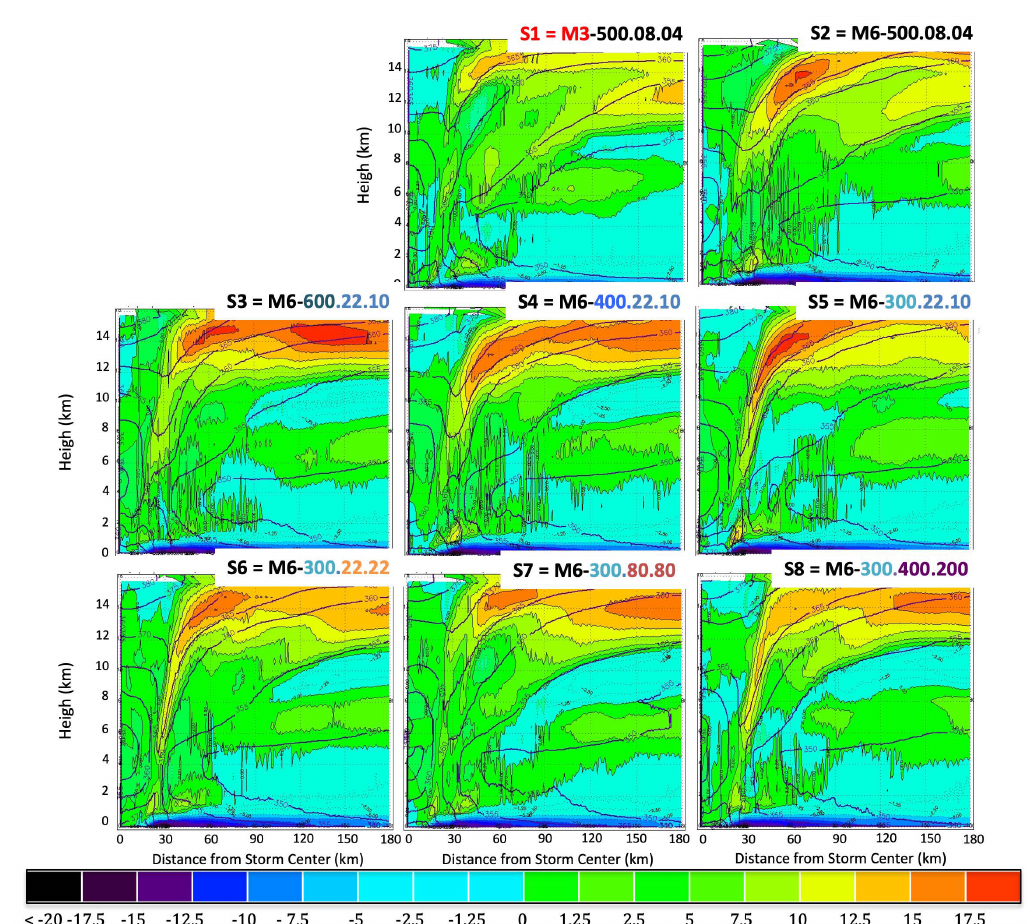
Figure 5. As in Figure 3, except shown is the horizontal and the vertical distribution of radial flow (in color). The contours show the equivalent potential temperature (as in Figure 4). The radial inflow is shown in different shades of blue, according to the intensity. The radial outflow is depicted in shades of green, orange and